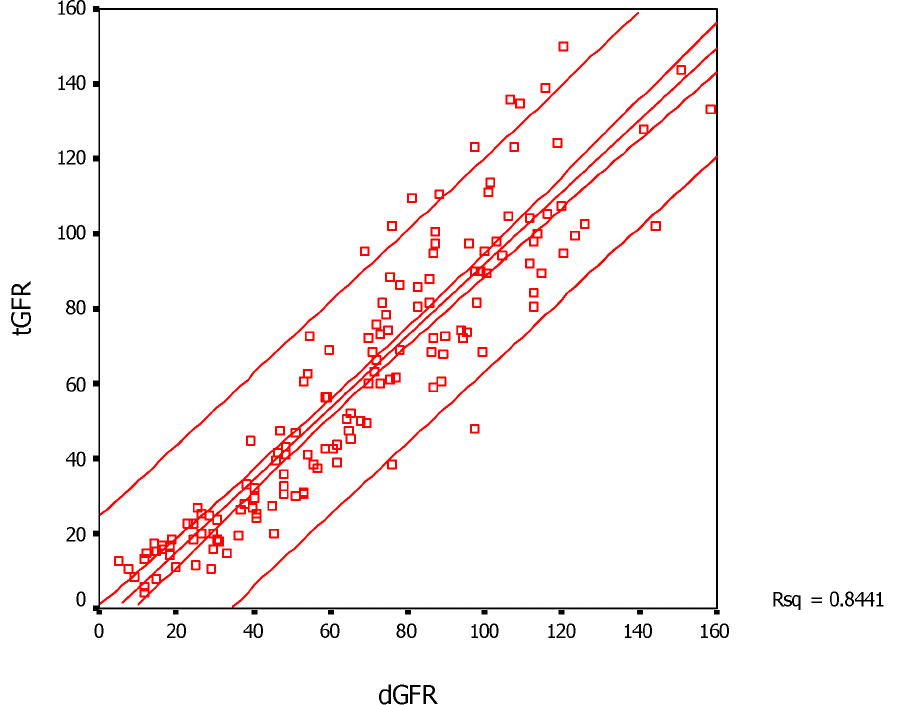
Figure 1. The scatter plot and linear regression of tGFR versus dGFR in 149 subjects. The center line represents the regression line and the surrounding lines show the 95% confidence interval of tGFR for a given dGFR. Abbreviations: dGFR- the GFR estimated by dynamic renal imaging method, tGFR- the GFR measured by dual plasma sampling method.